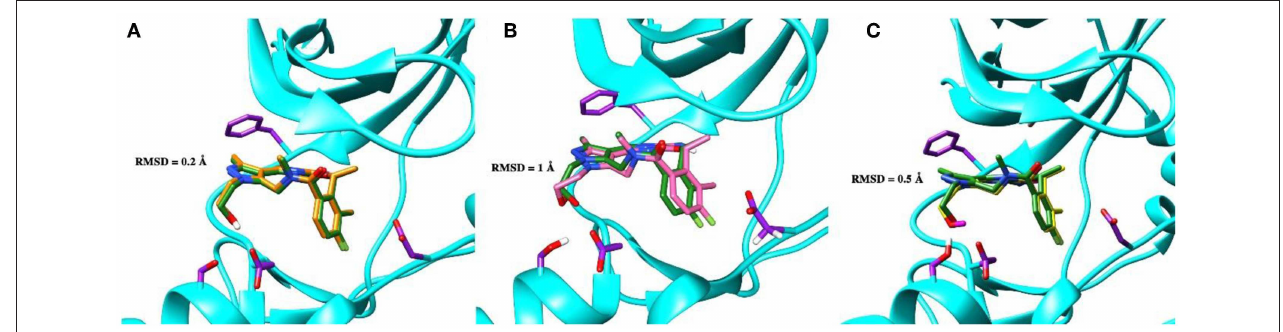
FIGURE 1 | The superposition of the crystal structure of macrocyclic compound 1 (shown in forest green ) with its docked pose performed by the GOLD ( A , orange ), MOE ( B , deep pink ), and AutoDock ( C , yellow ) software. The protein is represented as a secondary structure and highlighted in cyan . Some of the pocket residues are shown in licorice and colored in purple